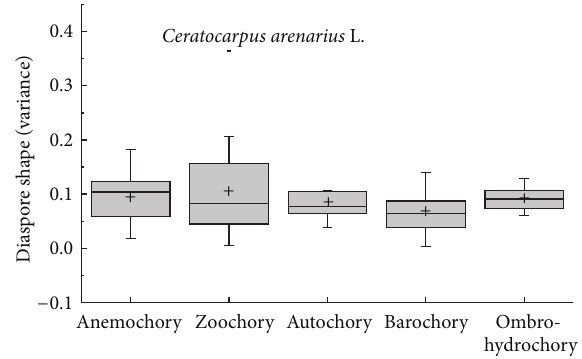
Figure 8: Box plots showing mean (+), median (—), quartiles, and outliers (-) of diaspore shape (variance) of 150 species grouped by different